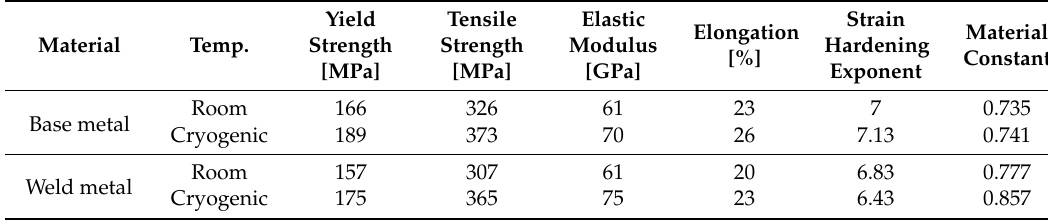
Table 3. Mechanical properties of the base metal and weldments.